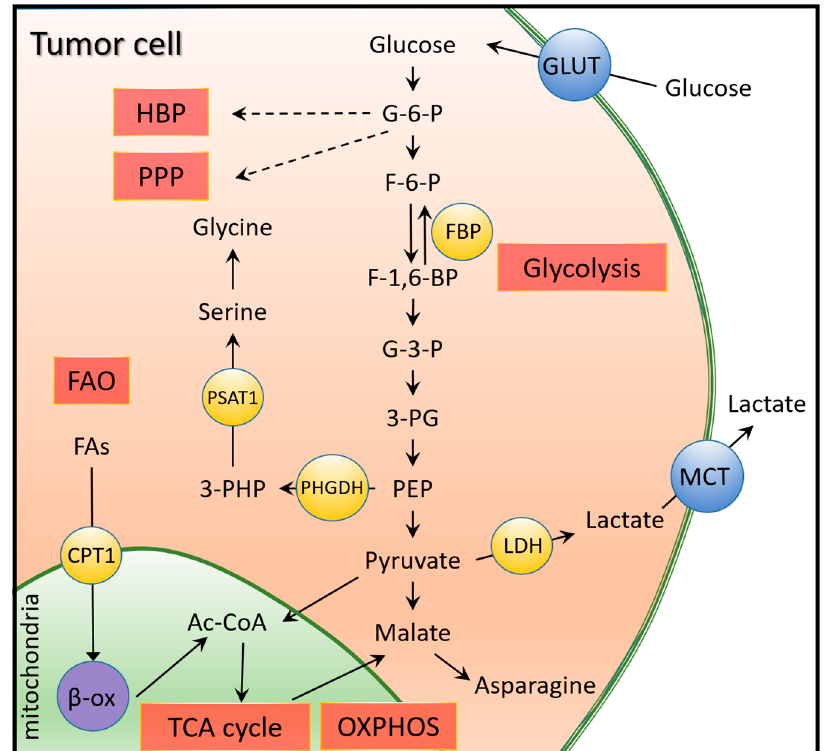
Figure 3. Glycolysis and its relationship with other metabolic pathways in TNBC. Due to higher glucose uptake in TNBC, the pyruvate produced from glucose enters the TCA cycle in mitochondria as Ac-CoA (acetyl coenzyme A). The malate that exits or is converted from pyruvate forms asparagine, whose high expression is associated with poor prognosis in TNBC. The high LDH (lactate dehydrogenase) expression allows elevated lactate efflux, which acidifies extracellular matrix and promotes tumor aggressiveness. Upregulated protein glycosylation via the hexosamine biosynthetic pathway (HBP) and increased NADPH production is described by upregulated pentose phosphate pathway (PPP) and serine synthesis. Additionally, higher fa tt y acid synthesis (FAO) characterized in TNBC also promotes the energy utilization of tumor cells.